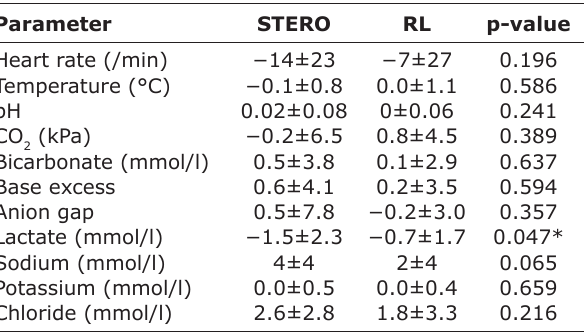
Table-4: Pre- and post-rehydration differences of vital parameters, venous blood gas values, lactate, and electrolytes before and after rehydration with acetated (STERO) or lactated (RL) rehydration fluids in 90 dogs compared with